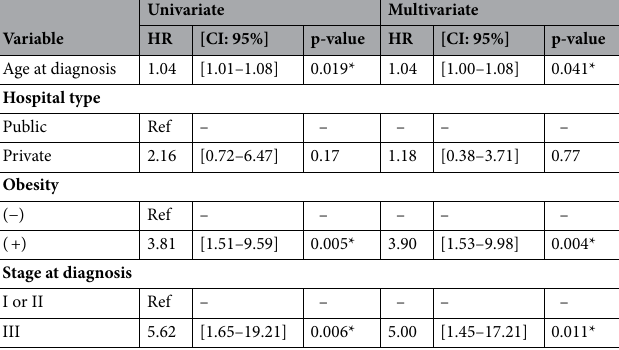
Table 2. Multivariate analyses of variables associated with survival. * indicates p <